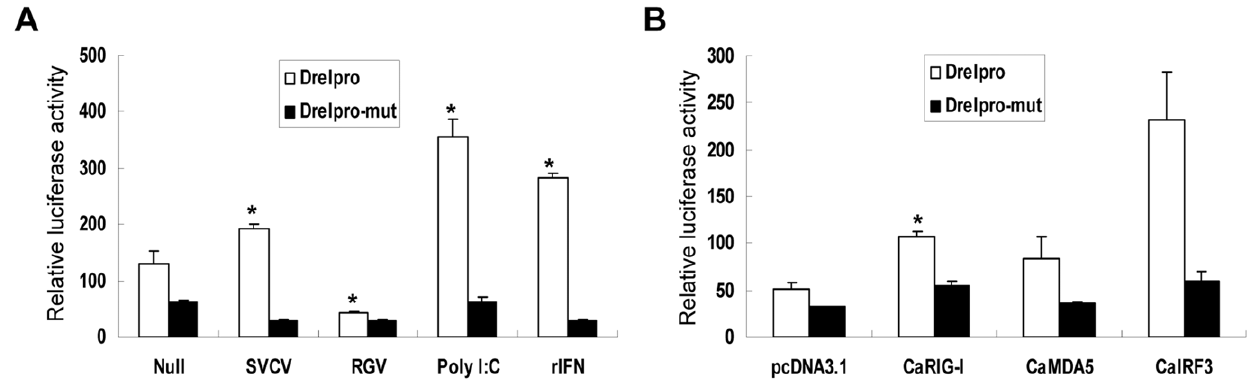
Figure 5. ISRE is essential for the induction of DreI promoter. (A) EPC cells seeded in 24-well plates overnight were transfected with DreI pro- Luc or DreI pro-mut-Luc plus pRL-TK and induced by SVCV, RGV, rIFN and poly I:C for 24 h. Cells were collected for measuring the luciferase activities. (B) EPC cells were cotransfected with pcDNA- CaRIG-I , pcDNA- CaMDA5 , or pcDNA- CaIRF3 and DreI pro-mut-Luc at the ratio of 1:1. In the control group, the EPC cells were cotransfected with indicated expression constructs and DreI pro-Luc at the ratio of 1:1. At 48 h posttransfection, the cells were collected to assess the luciferase activates. The results are the representative of three independent experiments and error bars are the SDs obtained by measuring each sample in triplicate. *p , 0.01.